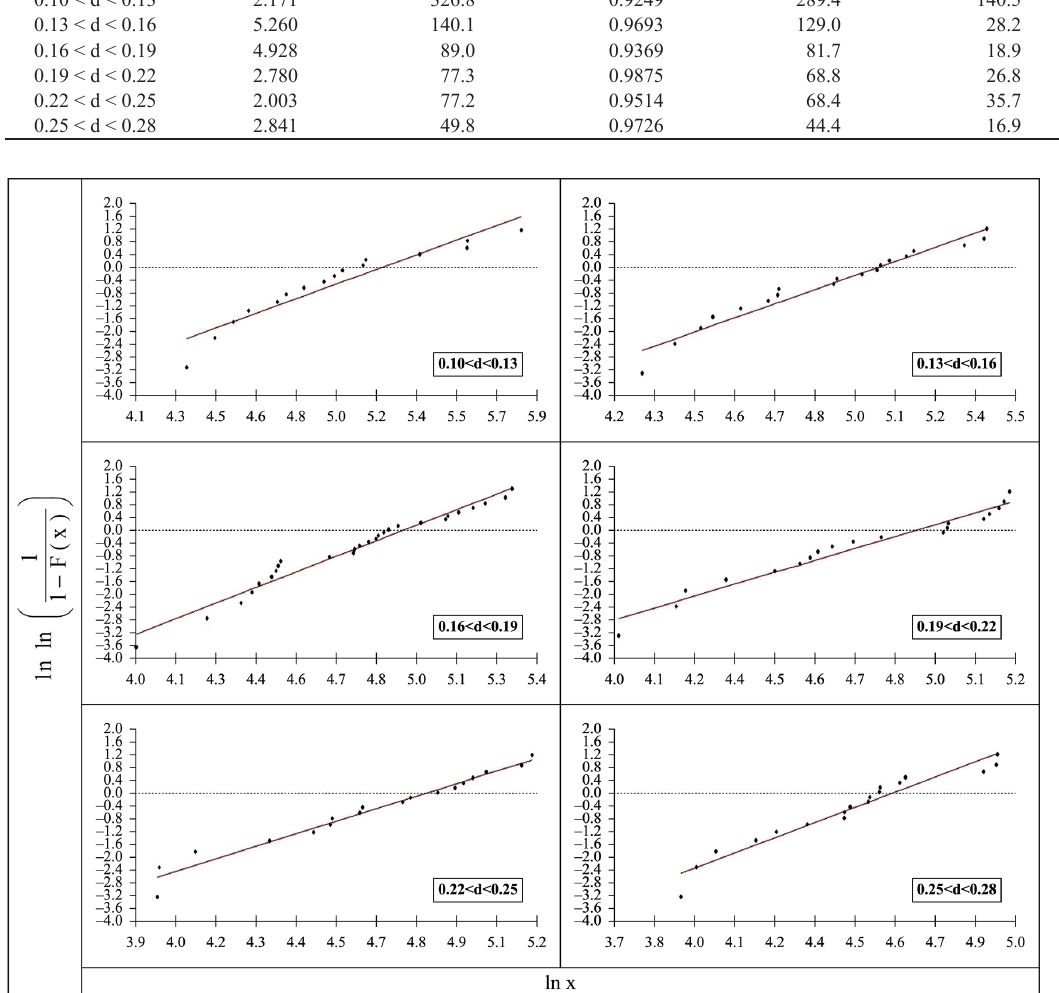
Table 2. Weibull parameters for the tensile strength of PALF fibers associated with different diameter interval. Diameter Interval (mm)